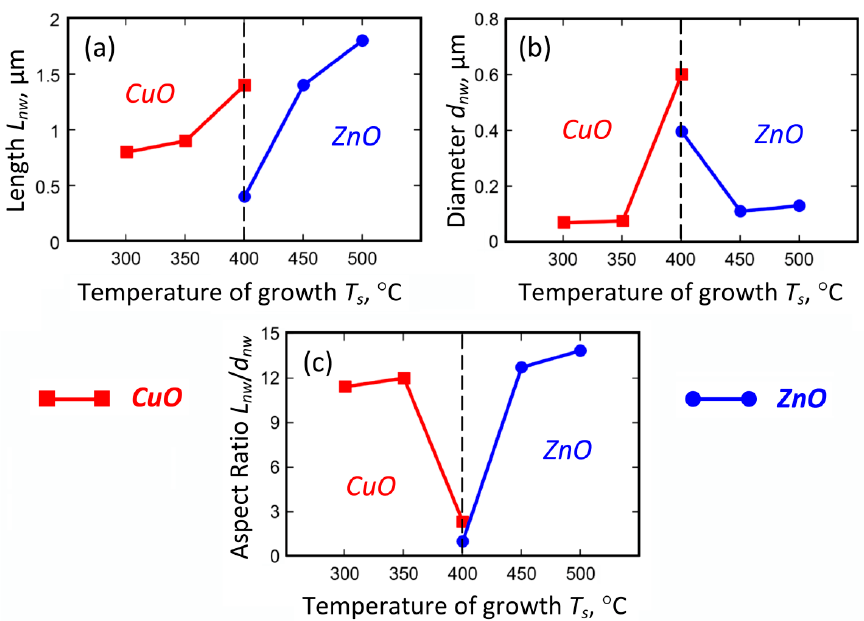
Figure8. ExperimentalresultsonmeasurementofCuOandZnOnanostructures: ( a )length; ( b )diameter; Figure 8. Experimental results on measurement of CuO and ZnO nanostructures: ( a ) length; ( b ) ( c ) aspect diameter; ( c ) aspect ratio.